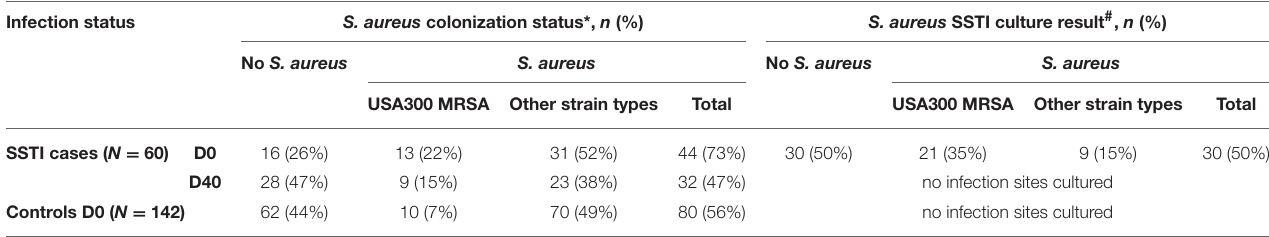
TABLE 2 | S. aureus colonization status for controls and for SSTI cases at D0 and D40, all of whom were cultured at three different body sites and also S. aureus infection status for SSTI cases cultured at one or more SSTI site on D0. Infection status